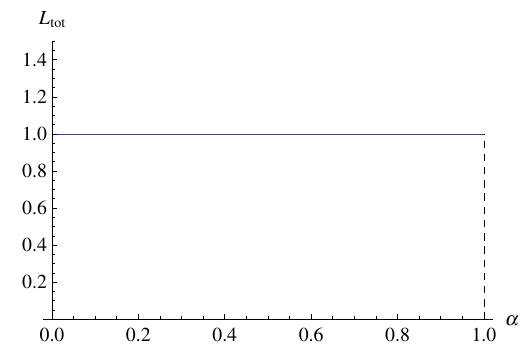
Fig. 15 Diagram of PDF for parameter α obtained as an intersection of the likelihood function. Two planes of the intersection likelihood function are H 0 = 68 . 82 and (cid:5) m , 0 = 0 . 3009. The planes of intersection are constructed from the best fitting value of the model parameters. We assume the value of α from the interval ( 0 , 1 ) . Note that the values of the likelihood function are not sensitive to changing of α